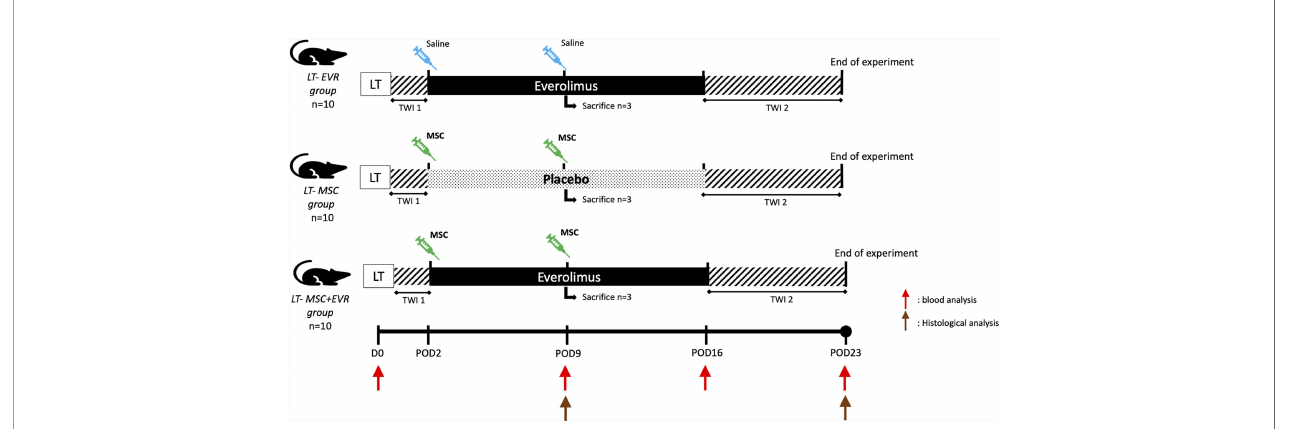
FIGURE 2 | Evaluation of the association of MSCs and everolimus in a liver transplantation model (experimental design). (EVR, everolimus; LT, liver transplantation; MSC, mesenchymal stromal cell; POD, post-operative day; TWI, time without immunosuppression -1: fi rst post-operative 48h, -2: from POD16 to POD23 (end of experiment); Red arrow, blood analysis; Brown arrow, histological